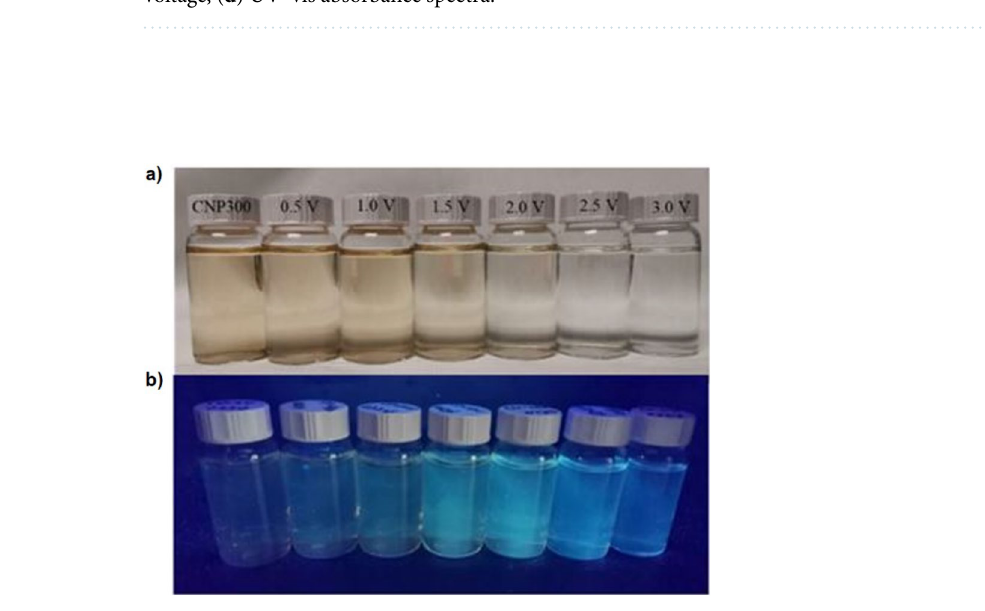
Figure 3. Photos of 0.02 mg ml –1 C-dots dispersions in 0.15 M KCl that has been subjected to chronoamperometry treatments for 60 s at applied voltages from 0.5 to 3.0 V compared to the untreated sample under ( a ) daylight and ( b )